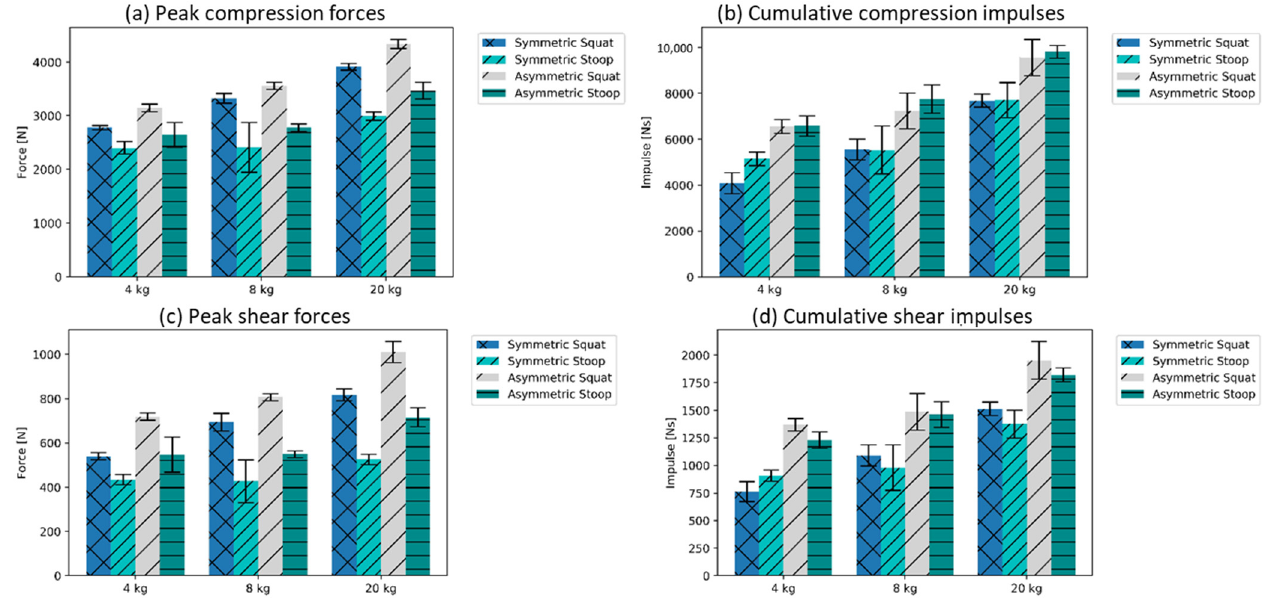
Figure 6. Forces and impulses in L4/L5 joint (± standard deviation (SD)).